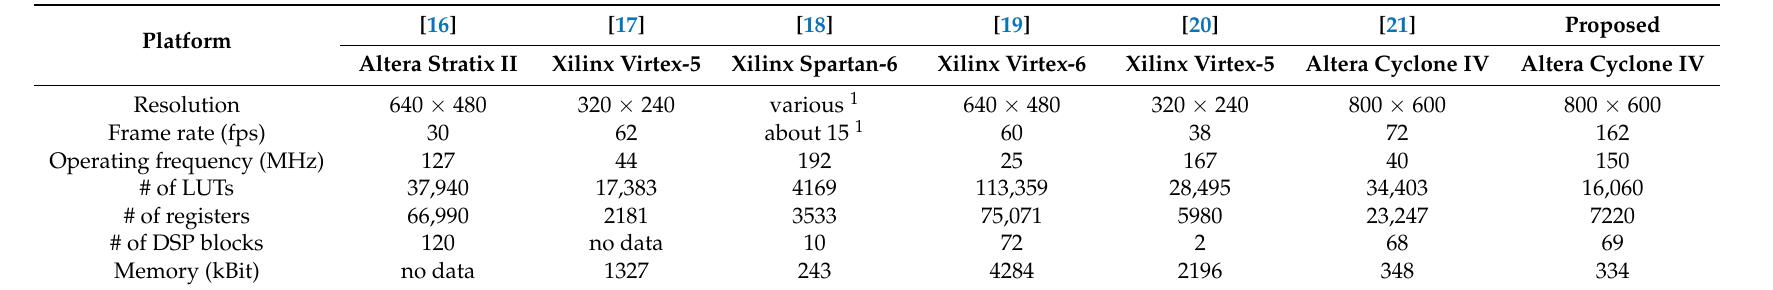
Table 3. Comparing this study’s resource utilization with other previous